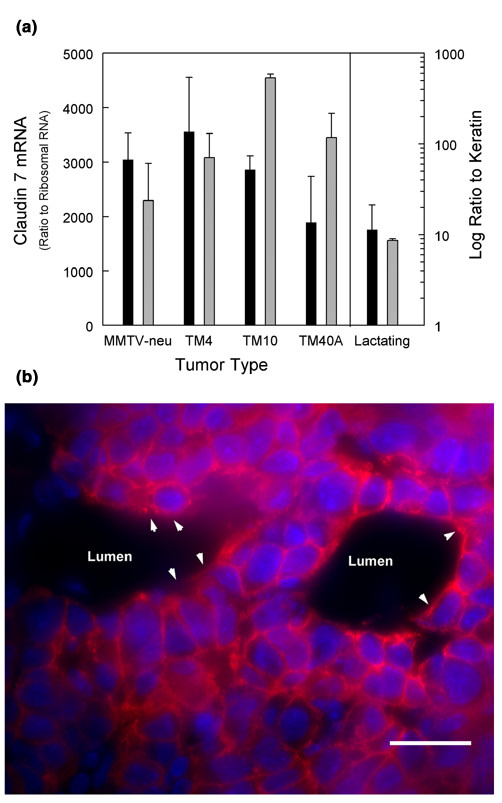
Claudin 7 in mouse mammary tumors. (a) Black bars, mRNA levels by real-time reverse transcriptase polymerase chain reaction in the four murine mammary tumors and the lactating gland, chosen for comparison because it, like the tumors, contains a large proportion of epithelial cells. All values are normalized to ribosomal RNA. Gray bars, Ratio of claudin 7 mRNA to keratin 19 mRNA. Error bars represent two SEM. (b) Claudin 7 distribution in paraffin section of the transplantable tumor TM4. The stain is localized to the perimembrane cytoplasm in all cells and excluded from nuclei. The arrowheads mark the point in which tight-junction stain would be expected if tight junctions were to form; however, no ZO1 stain was detected in the section. Scale bar, 20 μm.